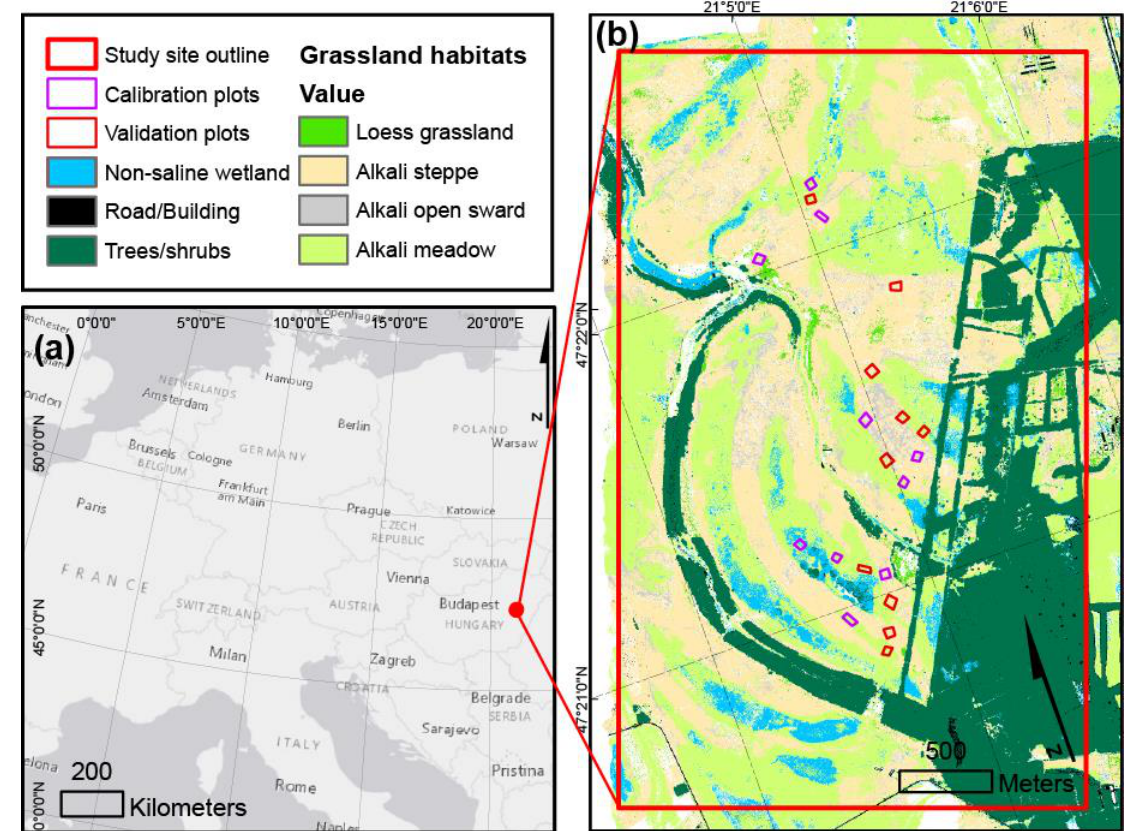
Figure 1. Location of the study site in Central Europe (a), overview of the study site including land cover, main alkali grassland classes and Natura 2000 conservation status reference plots. Reproduced with permission from